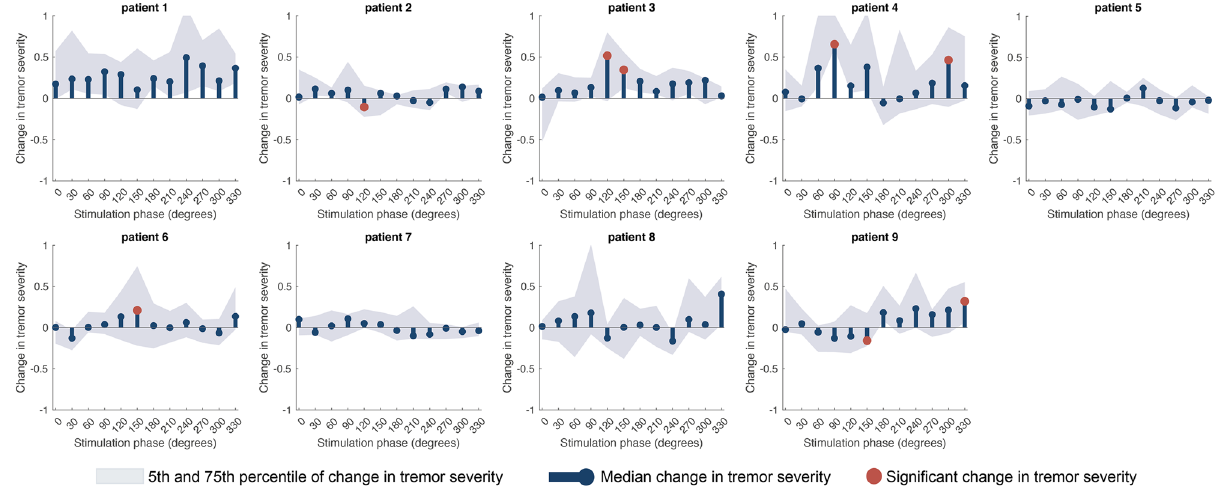
Figure 1. Patient-specific changes in tremor severity during phase-specific stimulation. The median change in tremor severity at the dominant (tracked) axis while stimulating at different phases of the tremor cycle (0°–330°), is shown by the stem plots in dark blue (amplitude response curves, ARCs). Change in tremor severity has been normalised so that 0 denotes no modulation of tremor severity, − 1 indicates complete tremor suppression and positive values indicate tremor amplification. The shaded light blue area represents the 25th and 75th percentile of change in tremor severity (across phase specific stimulation trials). Red dots indicate phases at which stimulation induced modulation of tremor is beyond natural variability of tremor. Note that half of the cohort has at least one stimulation phase where effects were significant and that only patient 9 shows statistically significant bi-directional (i.e., amplification and suppression) stimulation